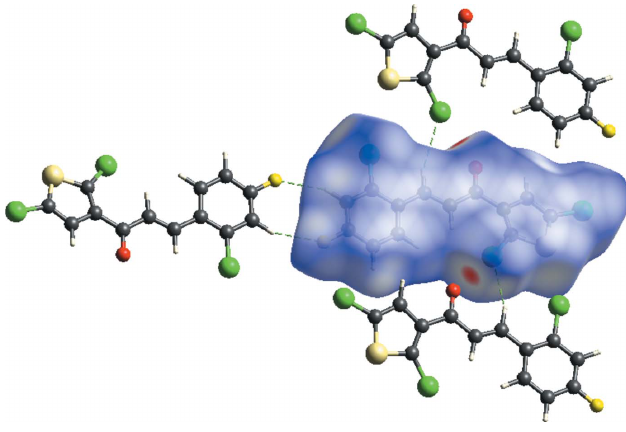
Figure 3 View of the three-dimensional Hirshfeld surface of the title compound mapped over d norm .